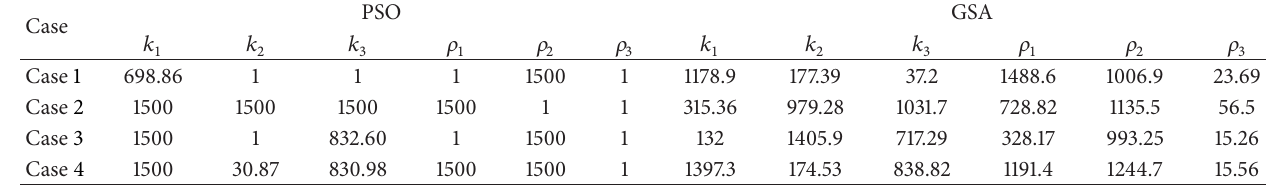
Table 2: Parameters of backstepping controller obtained from PSO and GSA techniques for each case.